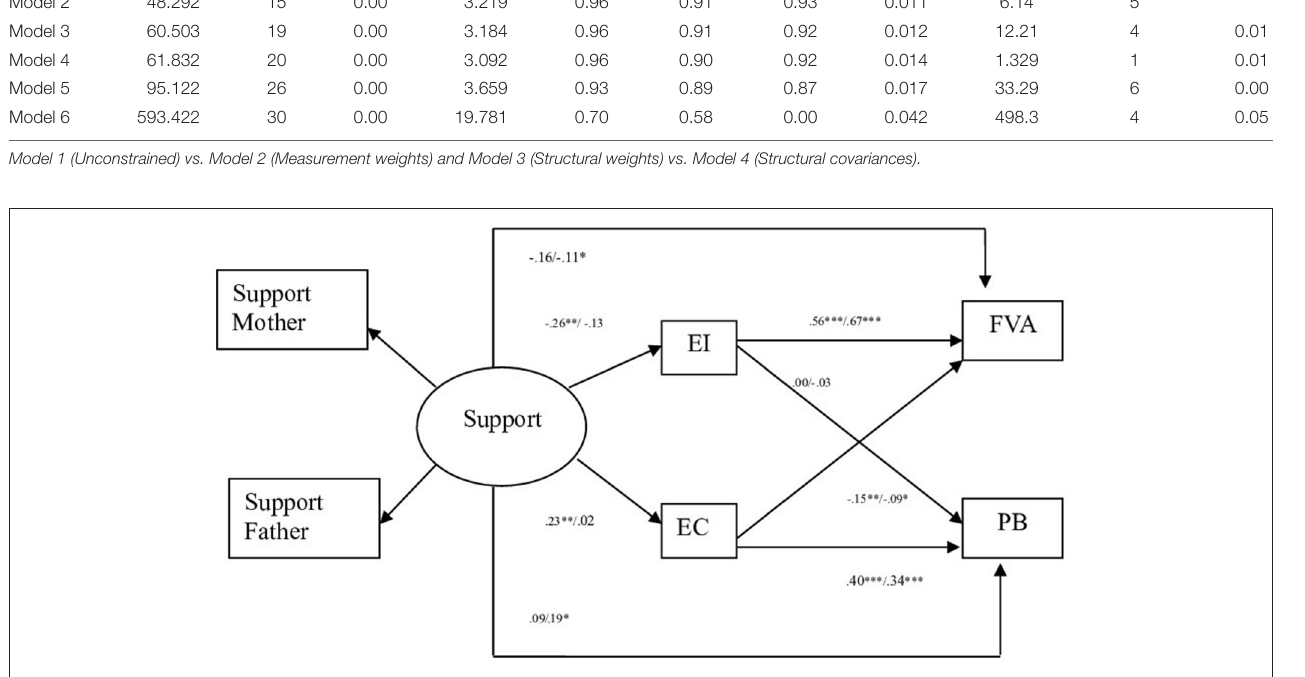
FIGURE 1 | Path standardized coefficient values of offenders and non-offenders pertinent to parental style support. Standardized Values. EI, Emotional Instability; EC, Empathic Concern; PVA, Physical and Verbal Aggressive Behavior; PB, Prosocial behavior. *** p < 0.001, ** p < 0.01, * p < 0.05. Non offenders left value, offenders right